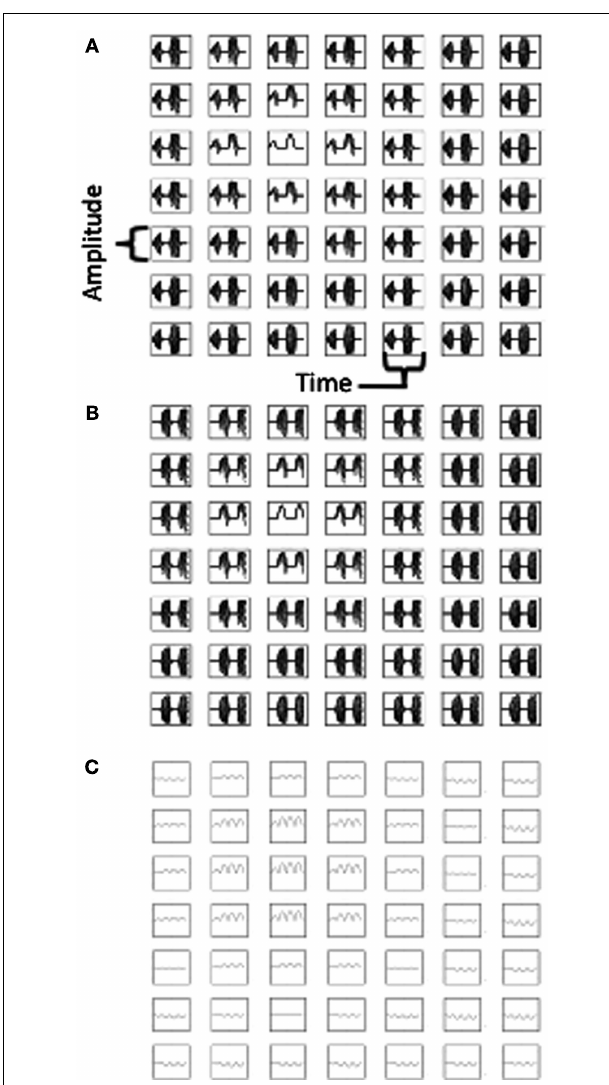
FIGURE 7 | Plots of neural activity over time. (A) Time course of activity of the heading angle cells in Group (A) representing different angles for a 7 by 7 array of heading angle spatial phases from the center of the population used in Figures 3 – 4 . (B) Time course of activity of the heading angle cells in Group (B) representing the same angles and spatial phases, but regulated to be active at different temporal phase (see text). (C) Time course of total synaptic input to the grid cell population showing oscillations that are double the frequency of the oscillations in Group (A) and Group (B) .The activity in (A,B) shows theta cycle skipping relative to activity in (C)